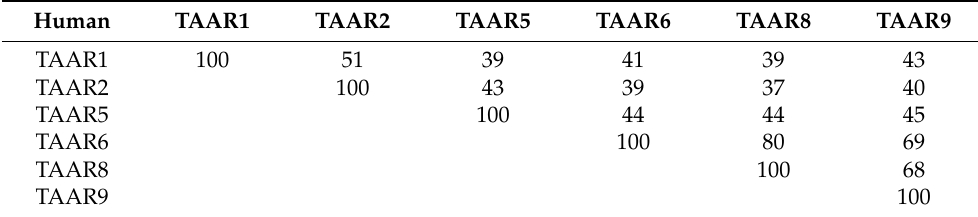
Table 2. Identity of human TAARs calculated using the BLAST program. Human TAAR1 TAAR2